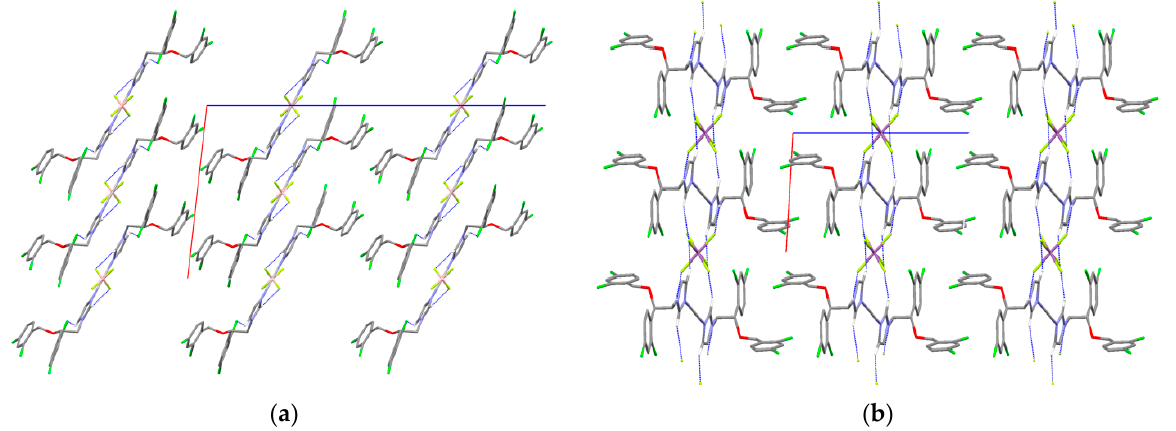
Figure 5. The crystal packing of 3 ( a ) and 4 ( b ) viewed along the crystallographic b axis.